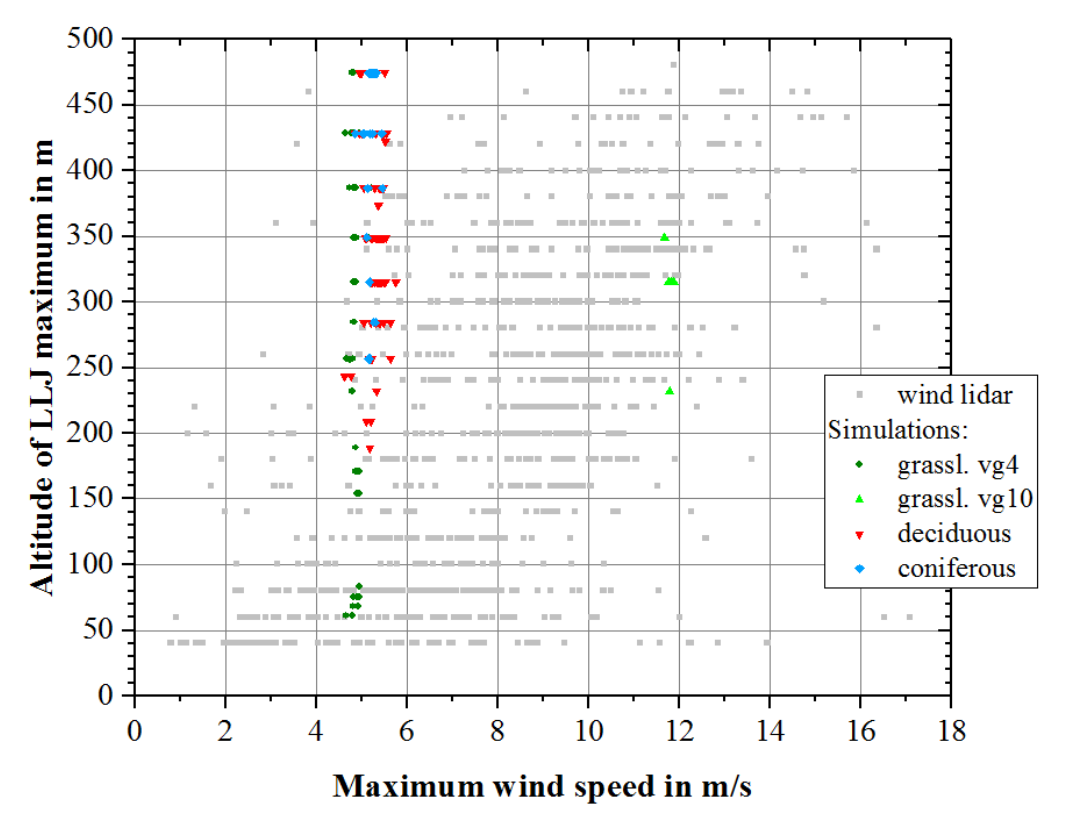
Figure 7. Comparison of maximum height and wind speed of measured (light grey) and simulated (grassland for v g = 4 and 10 ms − 1 : dark and light green, deciduous forest: red, coniferous forest: blue) LLJ events detected with the 0.5ms − 1 criterion for June